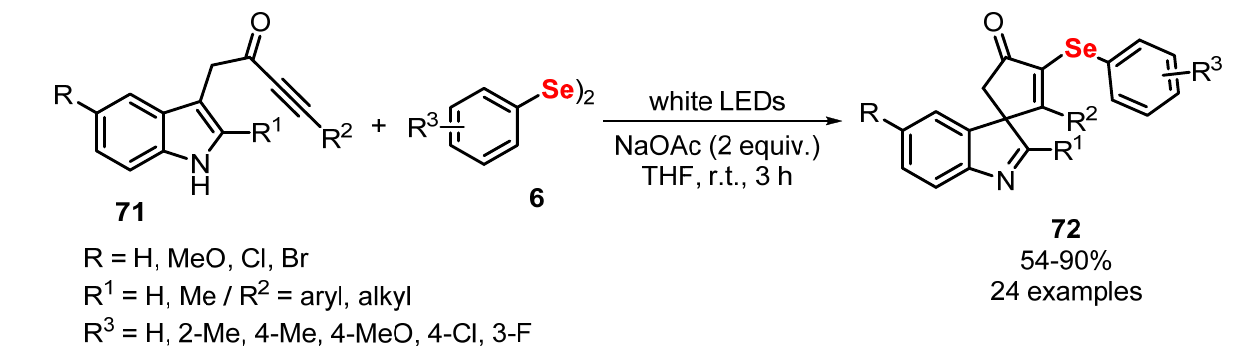
Scheme 33. Synthesis of 3 ‐ selenospiroindolenines 72 promoted by white LEDs.